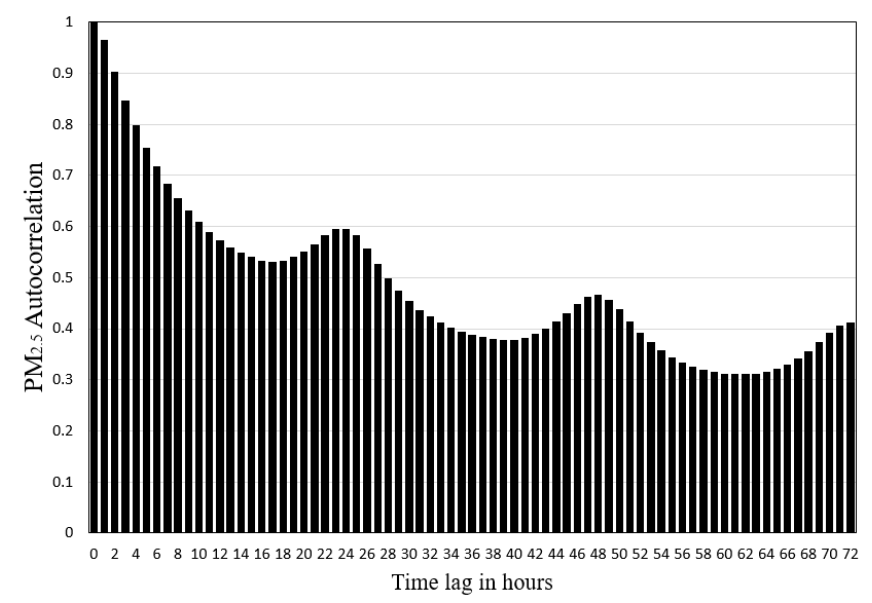
Figure 4. The autocorrelation characteristic of PM 2.5 series.